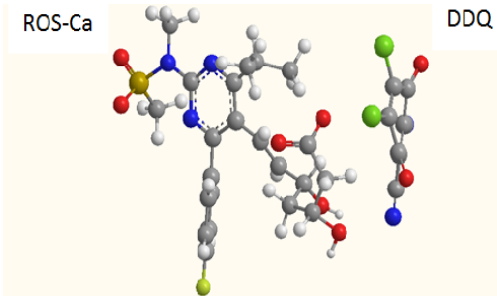
Figure 6. Energy-minimized CT complex of ROS-Ca with